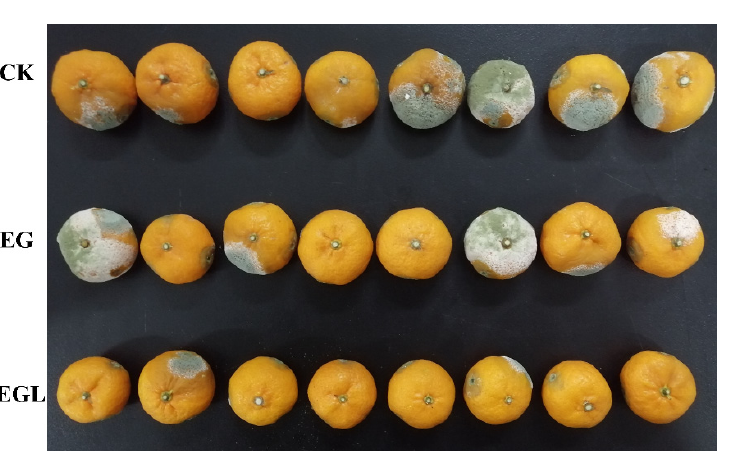
Figure 6. Challenge test of the citrus fruits treated with P. italicum after 5 d. Each group (8 fruits per replicate, n = 3) was injected with 10 μ L nanoemulsion (320 μ g/mL) into each cut, and the control group was treated with sterile water.